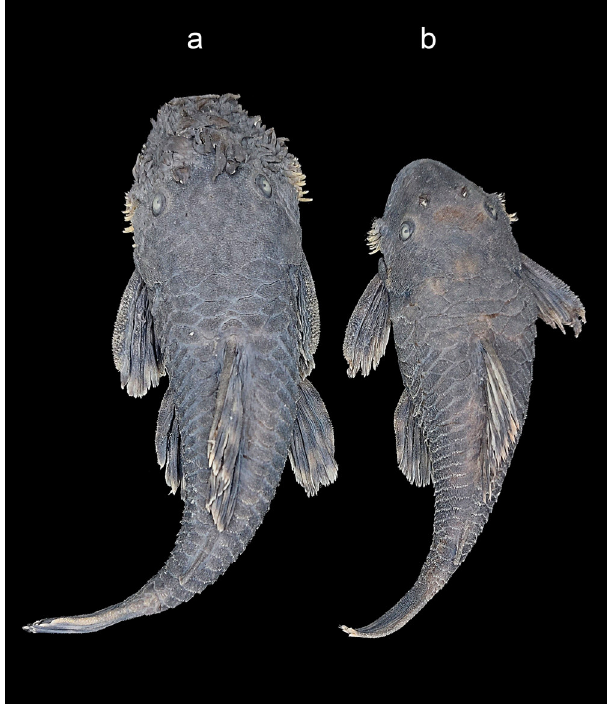
Figure 1. Male (a) and female (b) specimens of A. clementinae. Figure 1. Male ( a ) and female ( b ) specimens of A. clementinae